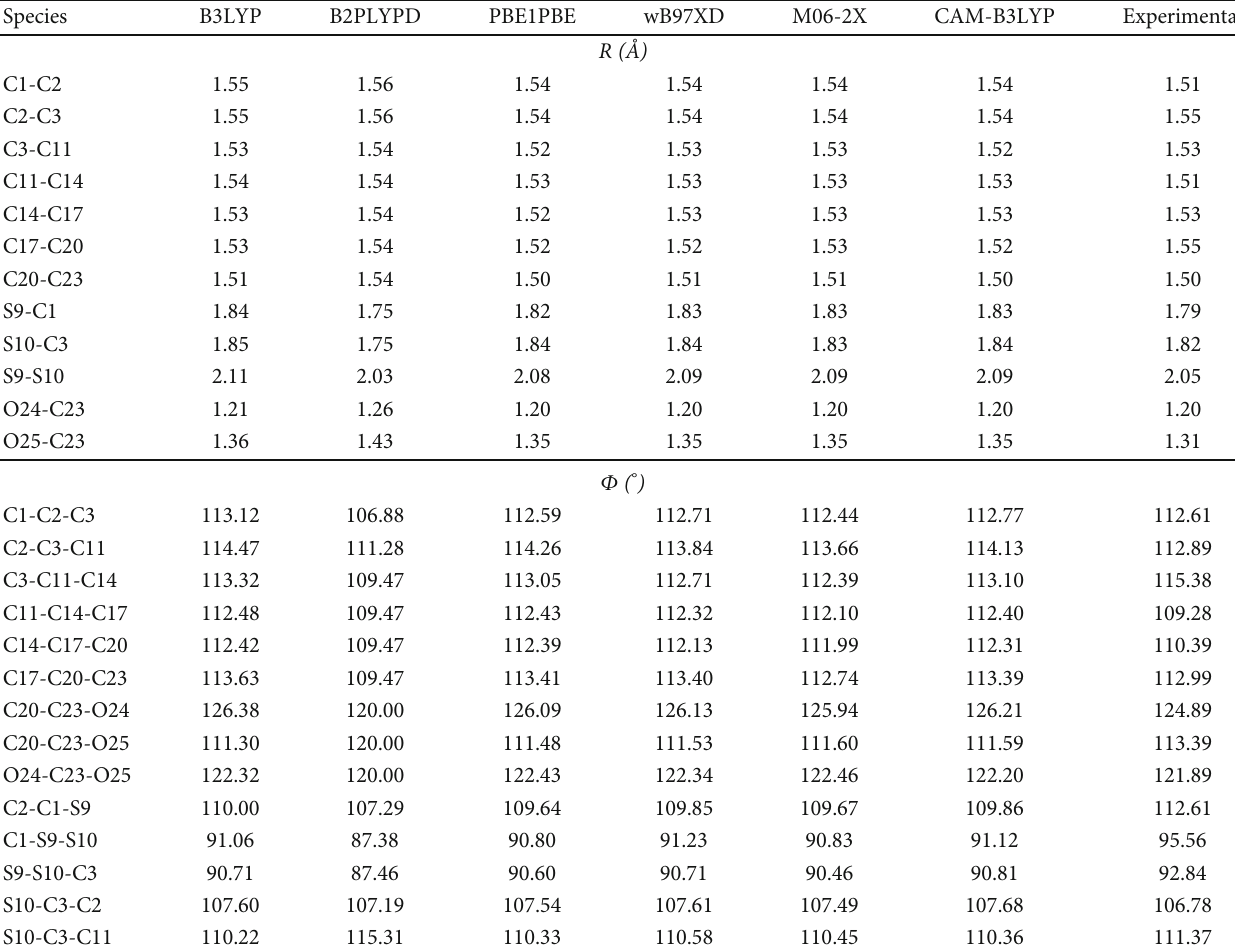
Table 1: The calculated bond lengths and bond angles of ALA [using the B3LYP, B2PLYPD, PBE1PBE, wB97XD, M06-2X, and CAM-B3LYP methods with the 6-311+G (d, p) basis set] and available experimental